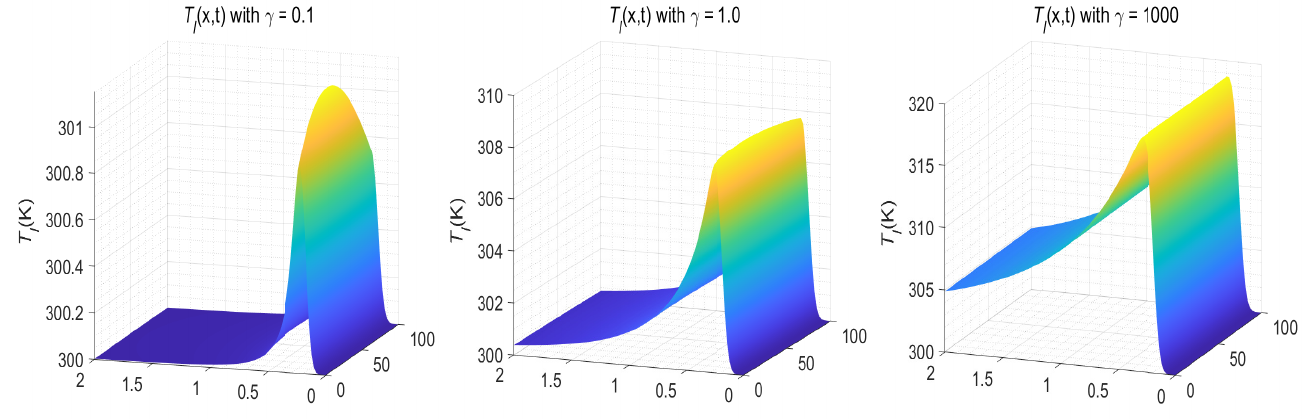
Figure 16. Temperature distributions of T l versus ( x , t ) with various γ when K n = 6.184658, ( α , β ) = ( 0.8,0.3 ) , N = 100, and M = 100 for Example